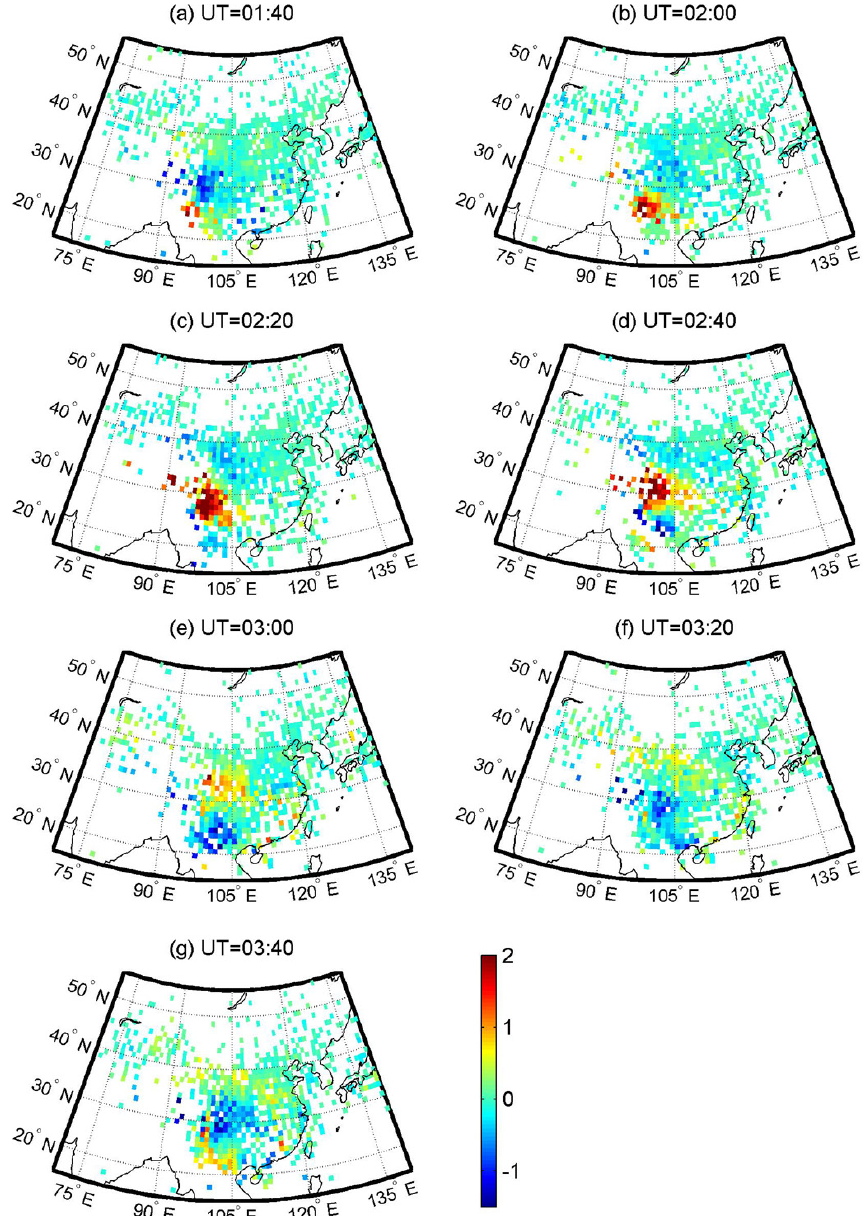
Fig. 3. Sequence of 2-D TEC maps over China between 01:40 and 03:40UT (i.e., 09:40–11:40LT) on 30 May 2011. The color interval represents the deviation of TEC (units: